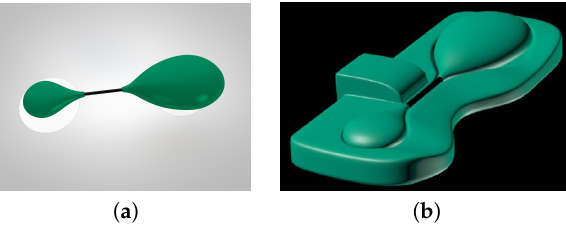
Figure 2. Savvy TM sensor ( a ) the wearable body sensor in bio-compatible housing with two self-adhesive electrodes attached; ( b ) the body sensor placed in the charging